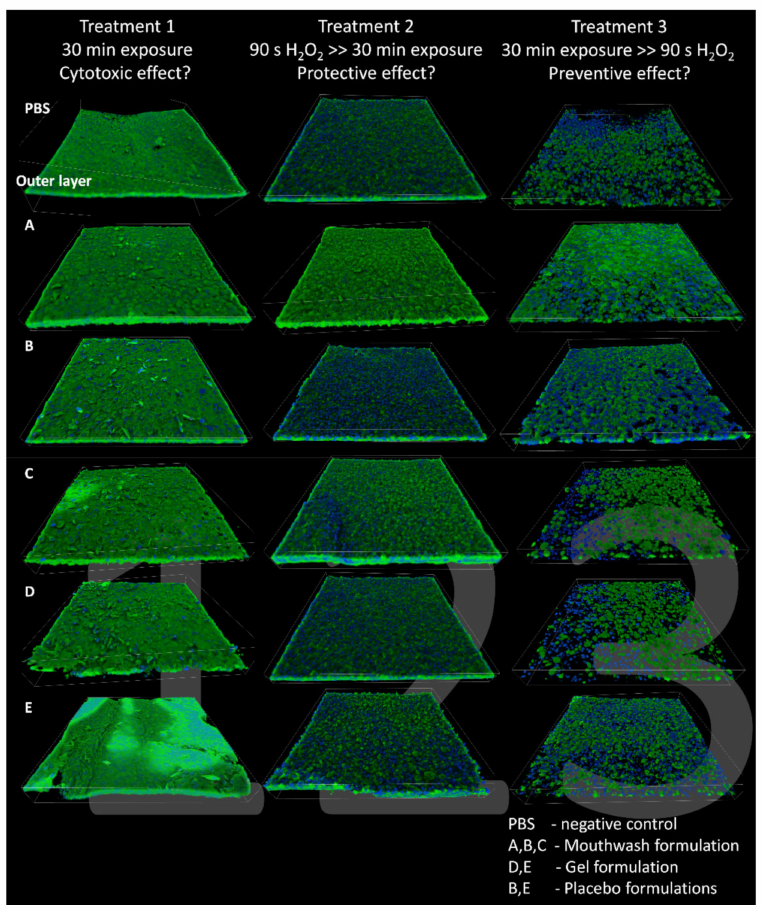
Figure 4. ( A – E ) 3D reconstructions of CLSM images (1270 × 1270 µ m) of RHOE specimens. Live cells fluoresce bright green, whereas dead cells with compromised membranes show their nuclei in blue fluorescence. Each picture letter indicates the corresponding formulation, while each column represents one of the three treatments performed. Due to limited dye penetration, the external uppermost part of the epithelia could be